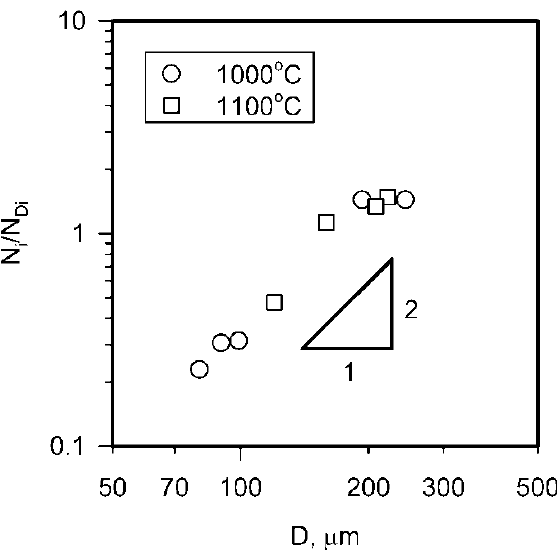
Figure 8. Relationship between the number of grain boundary interruptions per grain (N i /N Di ) and the grain size (D) in a 316L stainless steel subjected to recrystallization annealing followed by grain